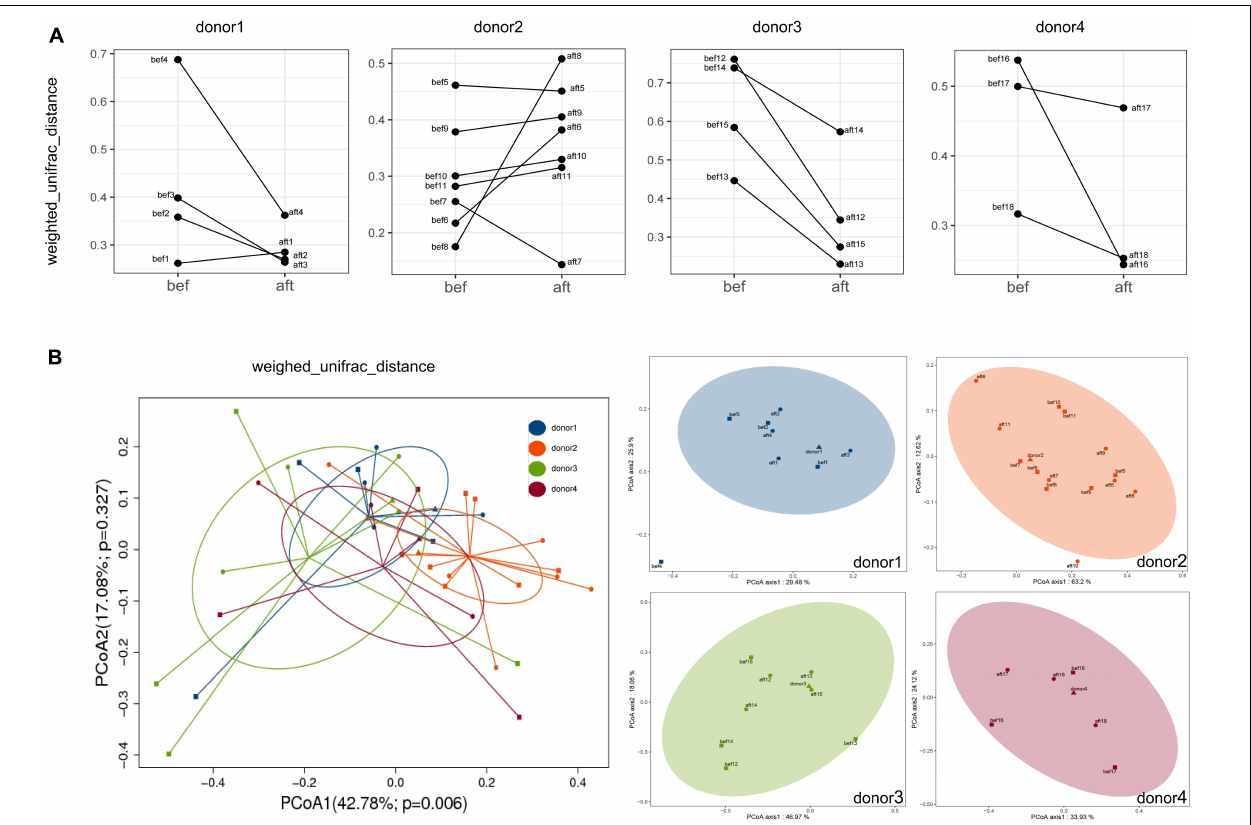
FIGURE 6 | Weighed UniFrac distances of each donor-recipient pair before and after FMT. (A) Each graph shows the changes in distance between recipients and their donor. Fecal microbial profiles of most recipients of Donor 1 and all recipients of Donors 3 and 4 became more similar to those of their donor, while most recipients of Donor 2 showed minimal change or became less similar to those of their donor. (B) PCoA of the microbiota compositions based on UniFrac distances showed the overall beta diversities of the 4 donors and the pre- and post-FMT samples of the 18 patients (left) and of each donor-recipient group (right).